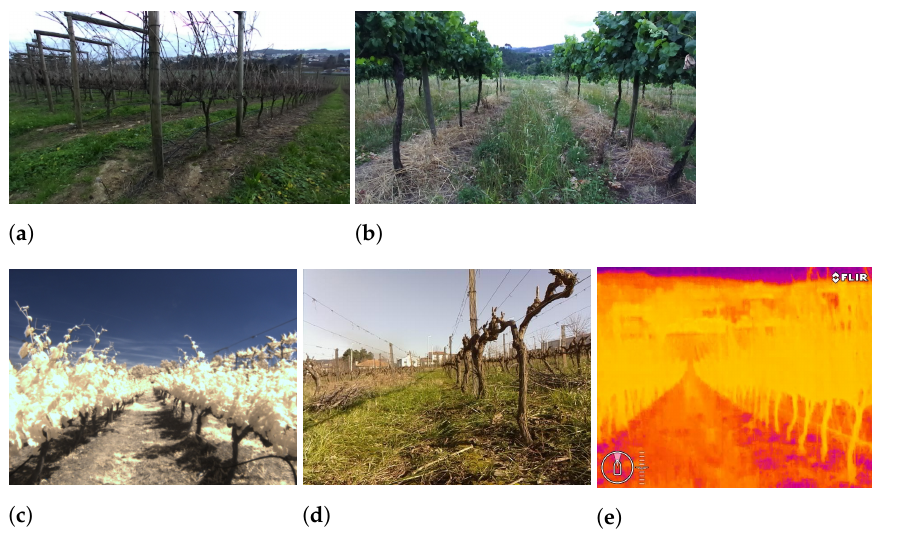
Figure 5. The five categories of vineyard images that compose the VineSet. ( a – d ) Four of them are from different Portugal Vineyards and ( e ) the other represents the set of thermal images of the vineyard present in Figure 5a.